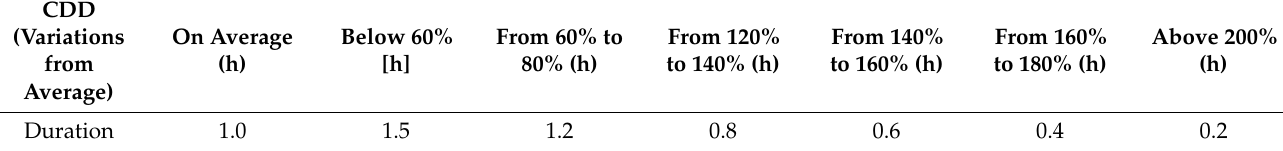
Table 5. DR event duration